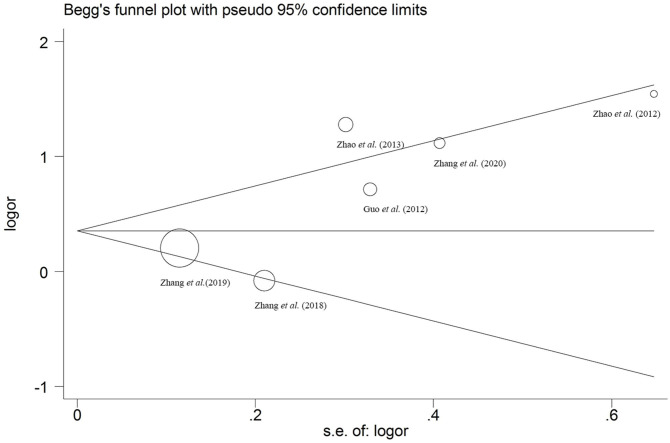
Begg's funnel plot of publication bias for a recessive model of MTHFR C677T polymorphism.